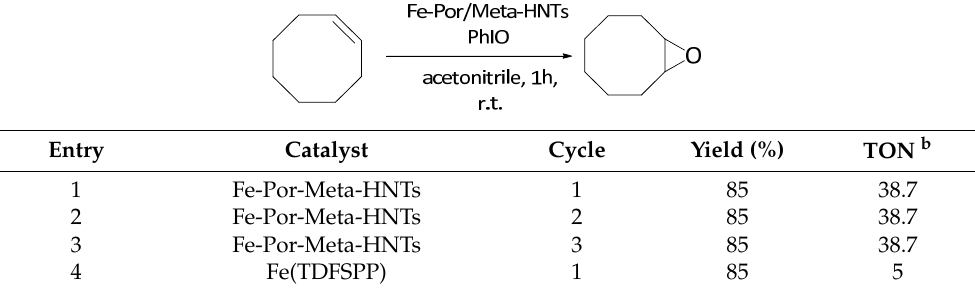
Table 1. Cyclooctenoxide yields achieved in the oxidation of cyclooctene by PhIO catalyzed by Fe-Por and FeMeta-HNTs [42] a . Adapted with permission from ref. [43].